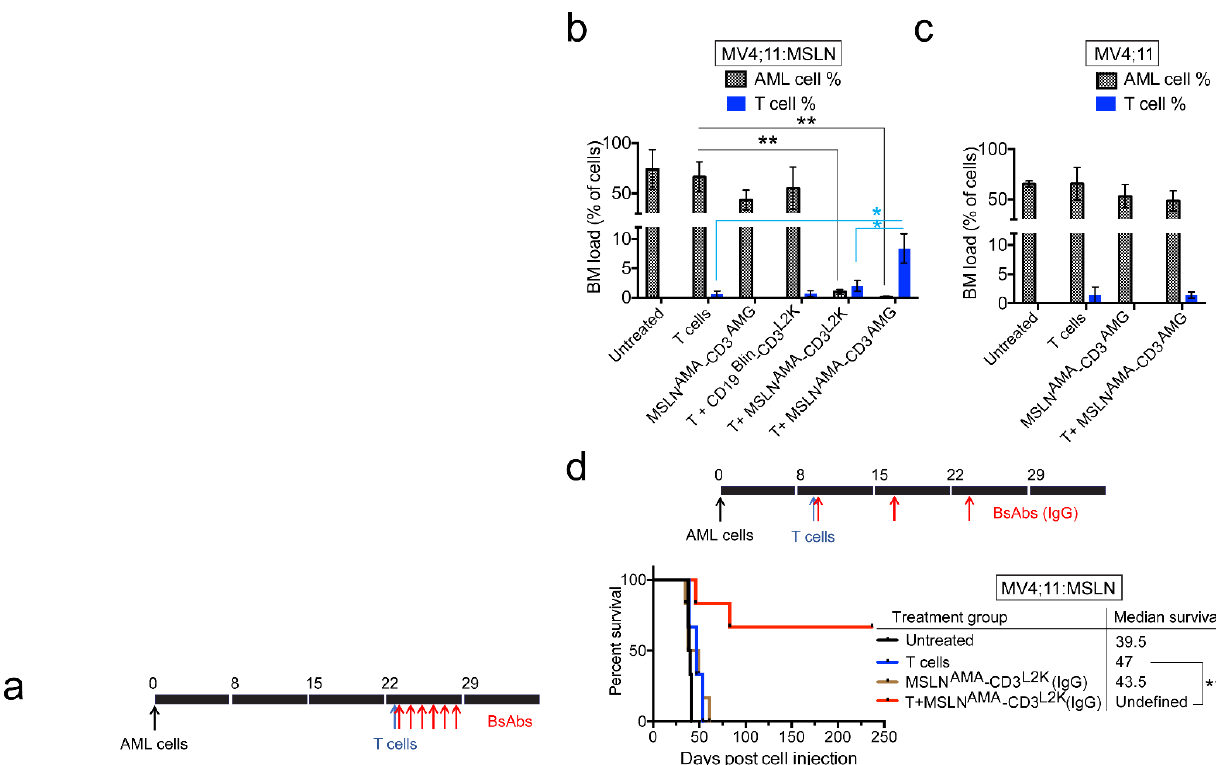
Figure 3. Efficacy of MSLN-targeting BsAbs in MV4;11:MSLN and MV4;11 xenograft models. ( a ) Schematic showing the dosing scheme for BsAbs. ( b , c ) Mice were euthanized when they reached pre-determined experimental endpoints. Bone marrow was flushed and stained with mouse specific CD45-APC, human specific CD45-Pacific blue and human specific CD3-FITC antibodies. Graph shows mean AML and T cell percentages in the bone marrow of mice engrafted with MV4:11:MSLN cells ( b ) or MV4;11 cells ( c ). Error bars denote SE of the mean. n = 5 per group. * p < 0.05, ** p < 0.005. ( d ) Schematic showing the dosing scheme for the IgG-based BsAb. Kaplan-Meier survival plot showing the median survival (** p < 0.01).